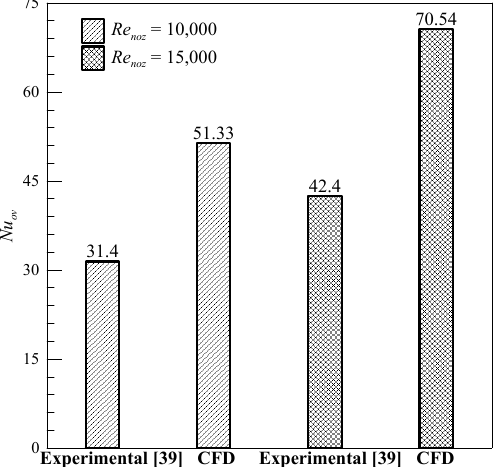
Figure 21. Experimental impingement cooling versus compound cooling at identical values of Re noz .